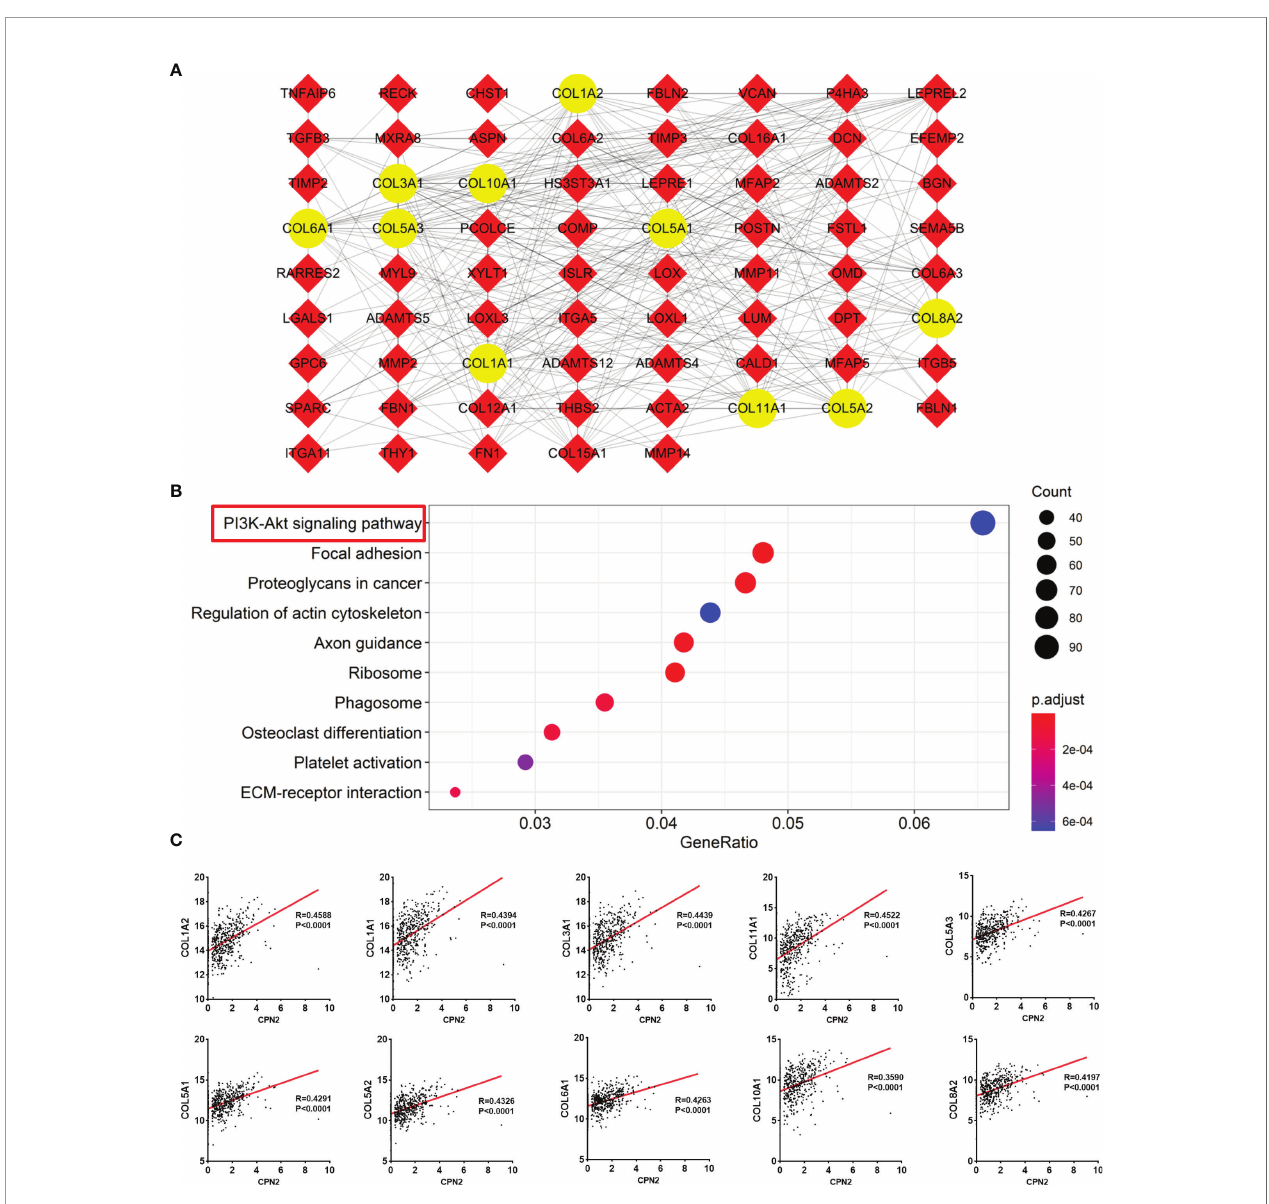
FIGURE 5 | Co-expression genes of CPN2 using Linkedomics analysis. (A) Protein – protein interaction of its co-expression genes. Co-expression genes with Pearson correlation coef fi cient >0.3 were gathered to draft this network, and the top 10 hub genes are shown in yellow color. (B) KEGG enrichment analysis of these co-expression genes. (C) Validation of 10 hub genes in The Cancer Genome Atlas lung adenocarcinoma